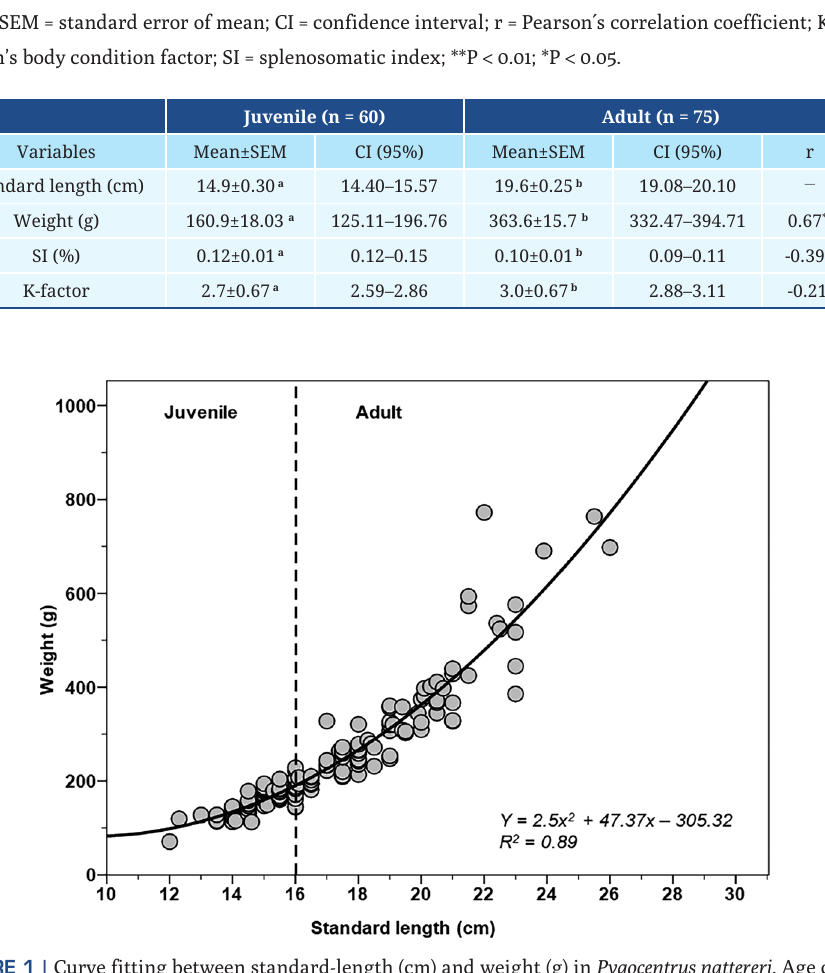
FIGURE 1 | Curve fitting between standard-length (cm) and weight (g) in Pygocentrus nattereri . Age cut off (16 cm) was applied according to Lowe-McConnell (1964).